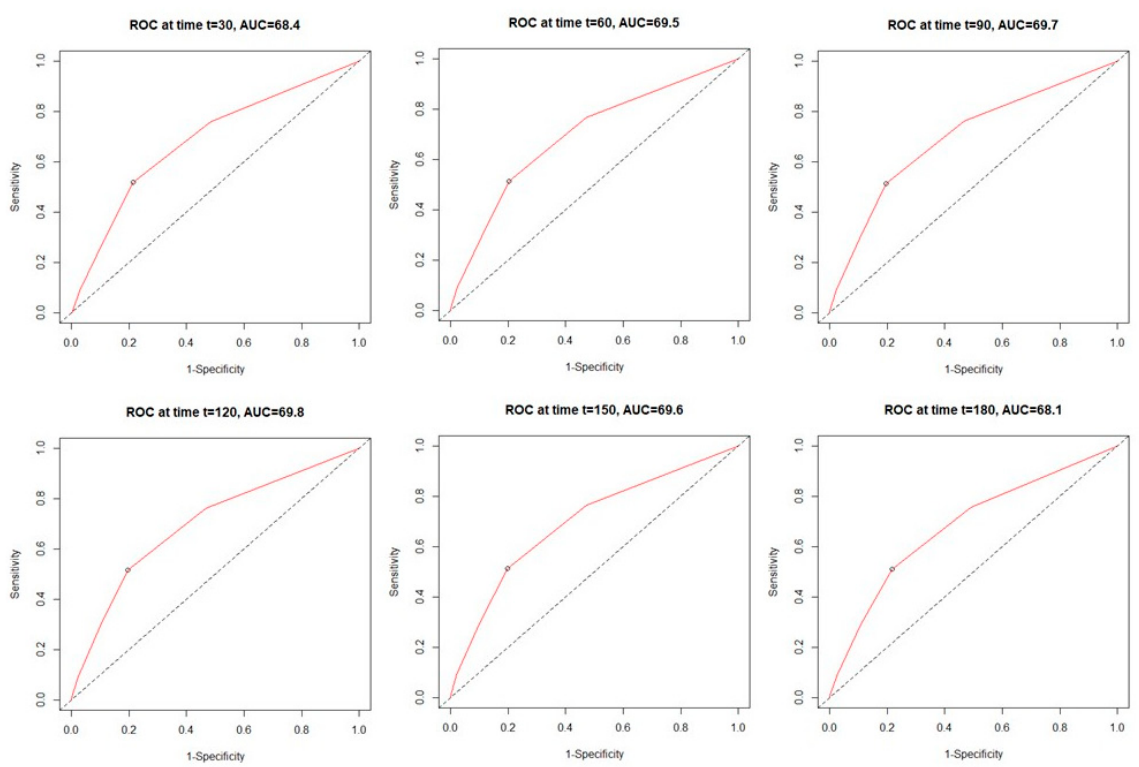
Figure 2. The time-dependent receiver operating characteristic (ROC) for all-cause mortality in the non-heart-failure cohort.